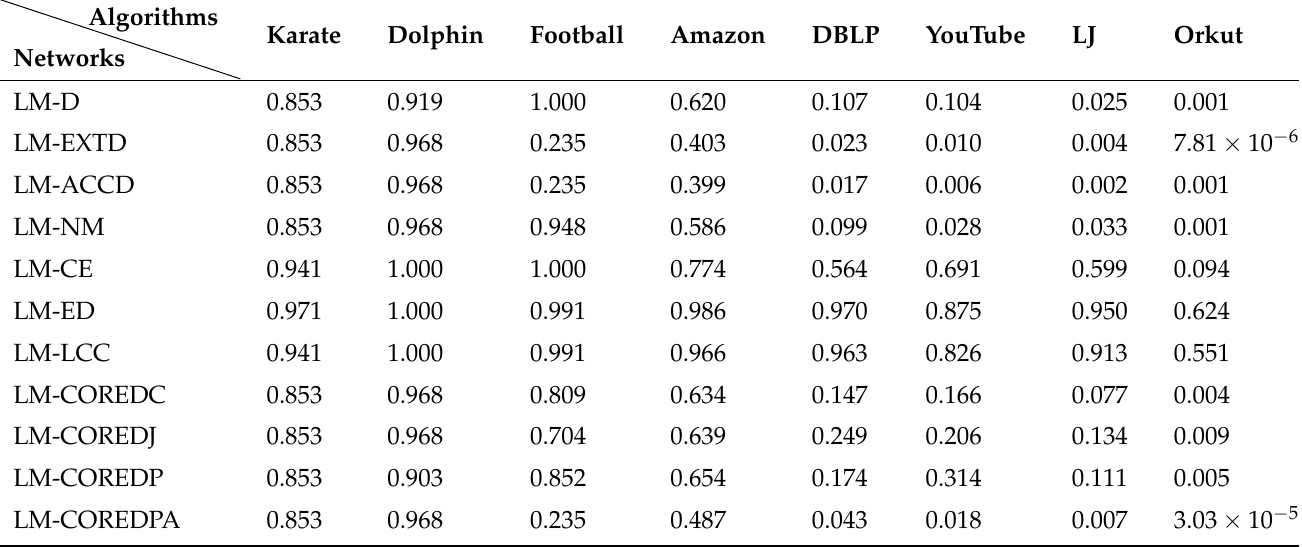
Table 5. The coverage of the resulting communities by different seeding